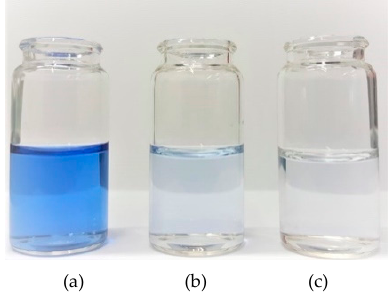
Figure 8. The solutions of the RBBR dye: ( a ) at initial concentration of 50 mg/L, ( b ) after decolorization using ZrO 2 –SiO 2 –laccase and ( c ) after decolorization using ZrO 2 –SiO 2 /Cu 2+ –laccase. Each of experiment was conducted at 30 °C and pH 4 within 24 h.